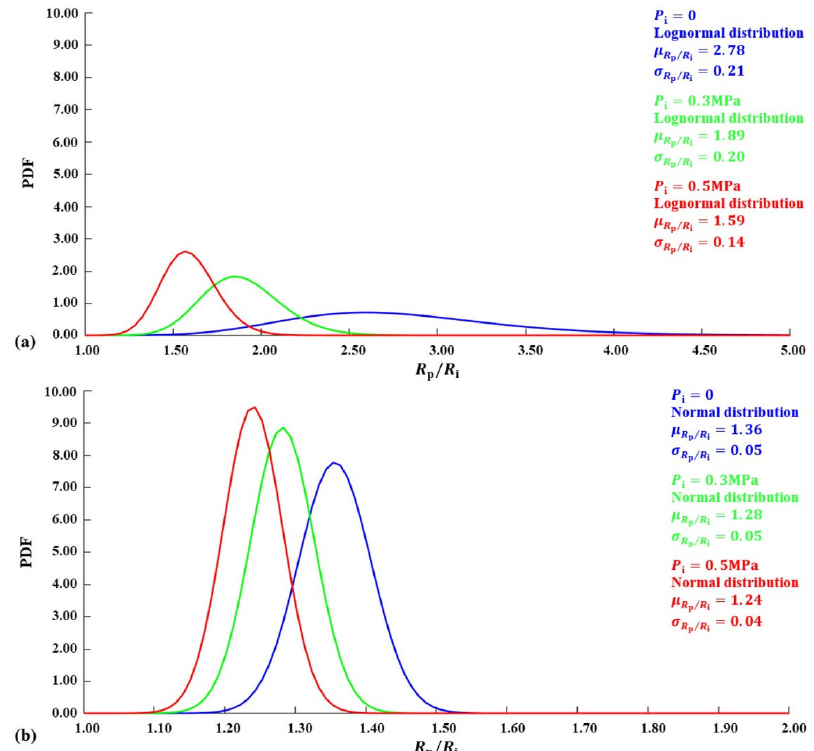
Figure 8. Probability Distribution Functions (PDF) of the plastic zone through Monte Carlo simulations: (a) Tunnel A; (b) Tunnel